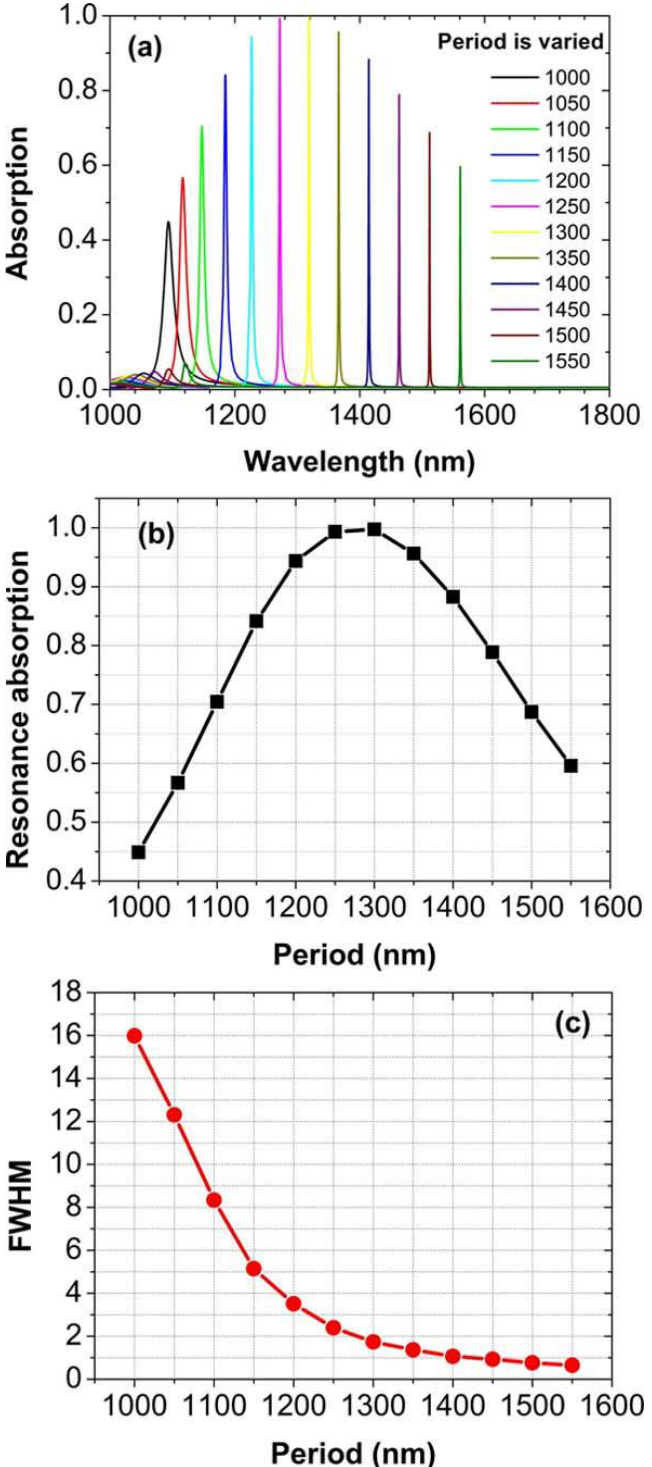
Figure 4. ( a ) Normal-incidence absorption spectra for the period ( p x = p y ) to be varied from 1000 to 1550 nm in steps of 50 nm. ( b , c ) Maximum value and FWHM of absorption peak for different peri- ods, respectively.